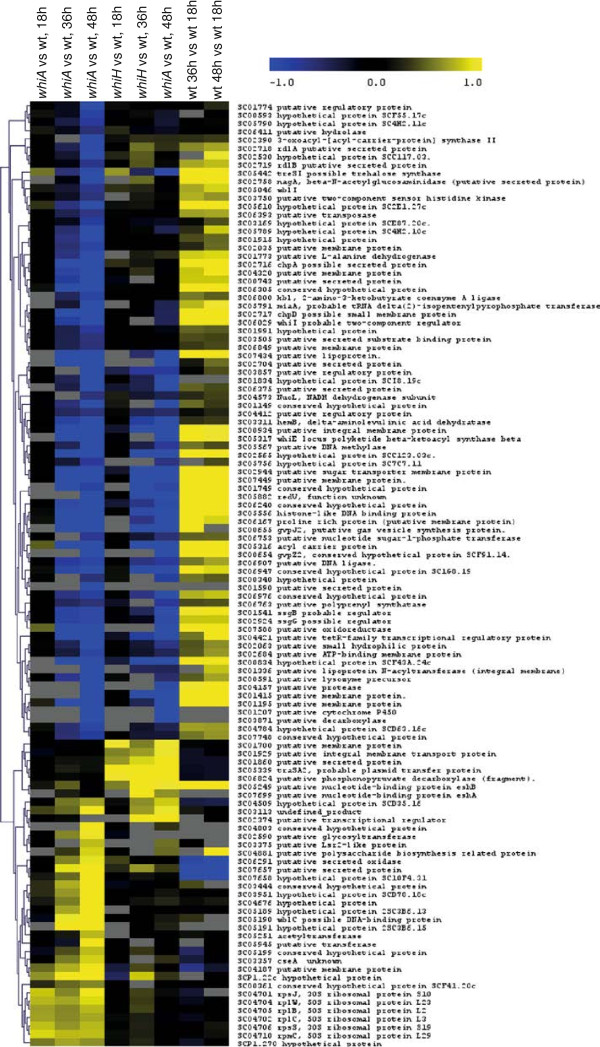
Hierarchical clustering of the 114 genes that were found to be significantly differentially expressed in at least one comparison between a mutant and the wild-type parent strain. A18, A36, and A48 refer to comparison of whiA mutant cDNA to wild-type cDNA prepared from developmental time points 18 h, 36 h, and 48 h, respectively. H refers to similar comparisons of whiH to wild-type at the given time points, and wt36 and wt48 refer to comparison of cDNA from wild-type strain at 36 h and 48 h, respectively, compared to the 18 h sample (as illustrated in Figure 
1). Colour-coded expression values (log2) are shown, where blue indicates lower expression and yellow indicates higher expression in mutant compared to wild-type (or in wild-type 36 h or 48 h sample compared to 18 h sample). Grey boxes indicate comparisons for which there is no expression value since not all four arrays showed at least one good spot.